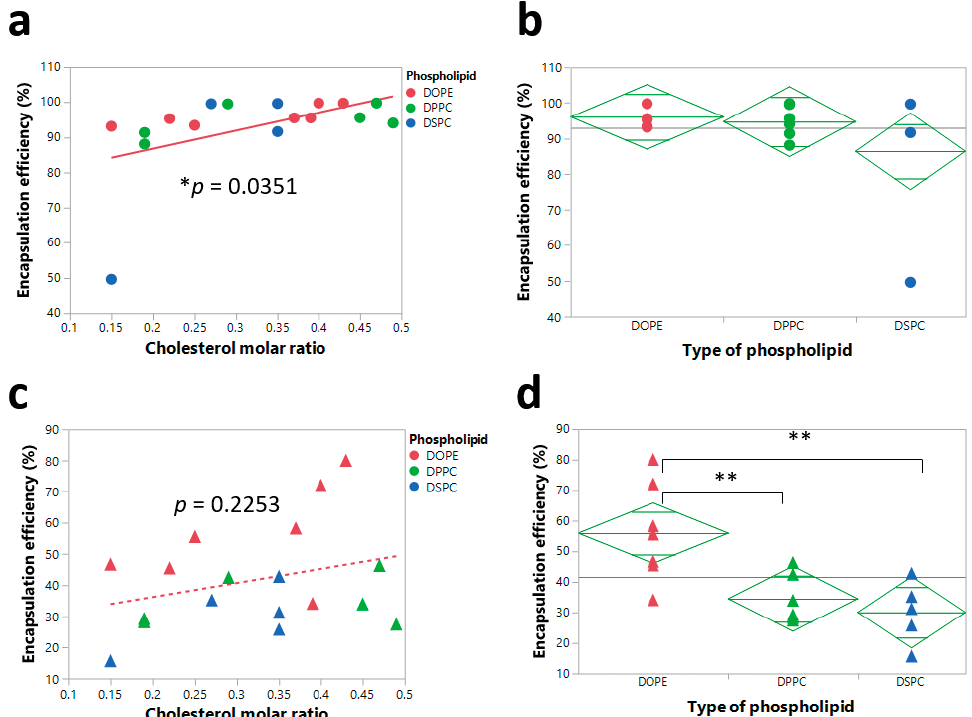
Figure 6. Correlation of encapsulation e ffi ciency and cholesterol molar ratio and type of phospholipid. Figure 6 . Correlation of encapsulation efficiency and cholesterol molar ratio and type of phospholipid. ( a ) Significant correlation (* p < 0.05) between encapsulation e ffi ciency and cholesterol molar ratio before ( a ) Significant correlation (* p < 0.05) between encapsulation efficiency and cholesterol molar ratio nebulization. ( b ) No significant e ff ects ( p > 0.05) of type of phospholipid on encapsulation e ffi ciency before nebulization. ( b ) No significant effects ( p > 0.05) of type of phospholipid on encapsulation before nebulization. ( c ) No significant correlation between encapsulation e ffi ciency and cholesterol efficiency before nebulization. ( c ) No significant correlation between encapsulation efficiency and molar ratio after nebulization. ( d ) Significant e ff ects of type of phospholipid on encapsulation e ffi ciency cholesterol molar ratio after nebulization. ( d ) Significant effects of type of phospholipid on after nebulization. ** p < encapsulation efficiency after nebulization. ** p < 0.01.